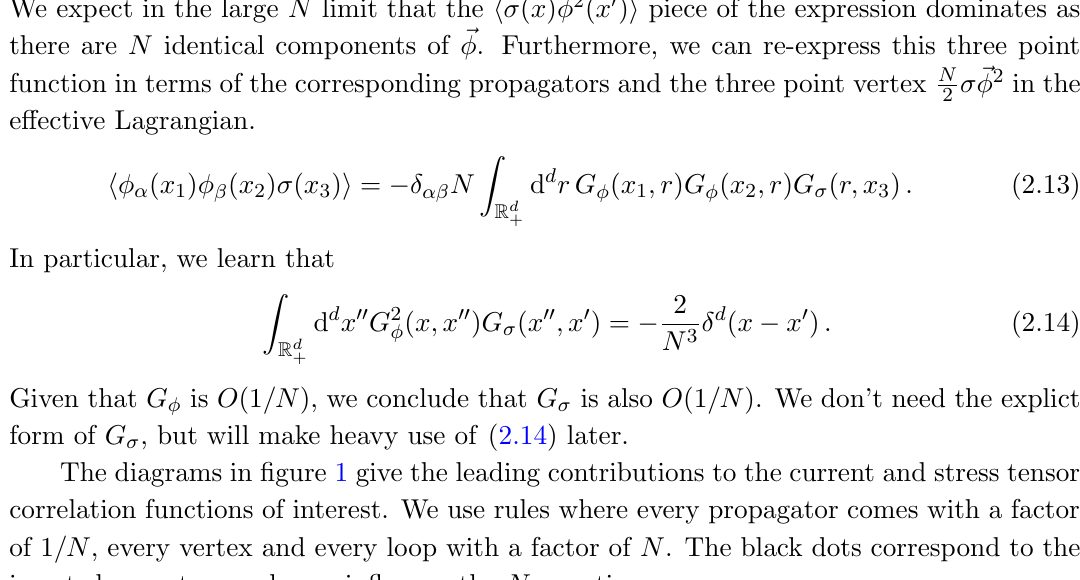
Figure 1 . The Feynman diagrams needed for computing the h J (cid:11)(cid:12) correlation functions at leading order in N . Diagrams (a) and (b) contribute to h J (cid:11)(cid:12) at order N 0 while (c) vanishes because of the antisymmetrization over the O ( N ) indices. For h T (cid:22)(cid:23) ( x ) T (cid:21)(cid:26) ( x 0 ) i , all three diagrams contribute an amount proportional to N . The solid lines are (cid:30) (cid:11) propagators while the dashed line is a (cid:27)